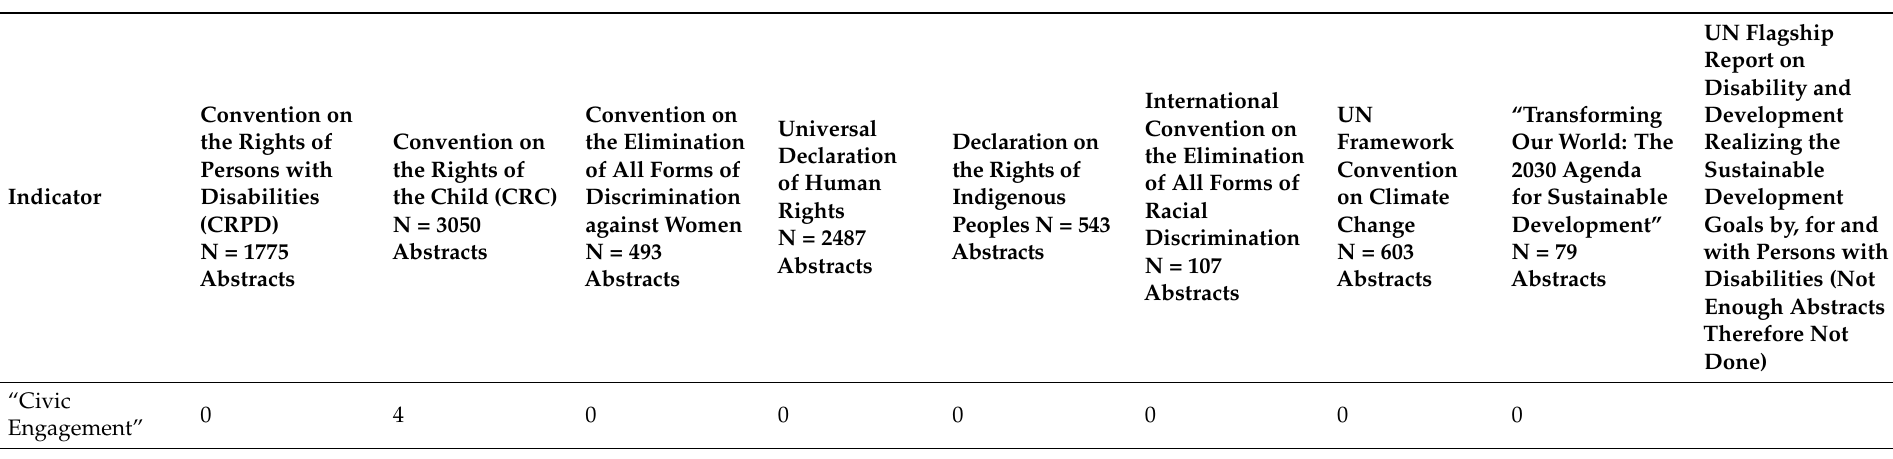
Table 13. Presence of Better Life Index indicators in abstracts mentioning “the